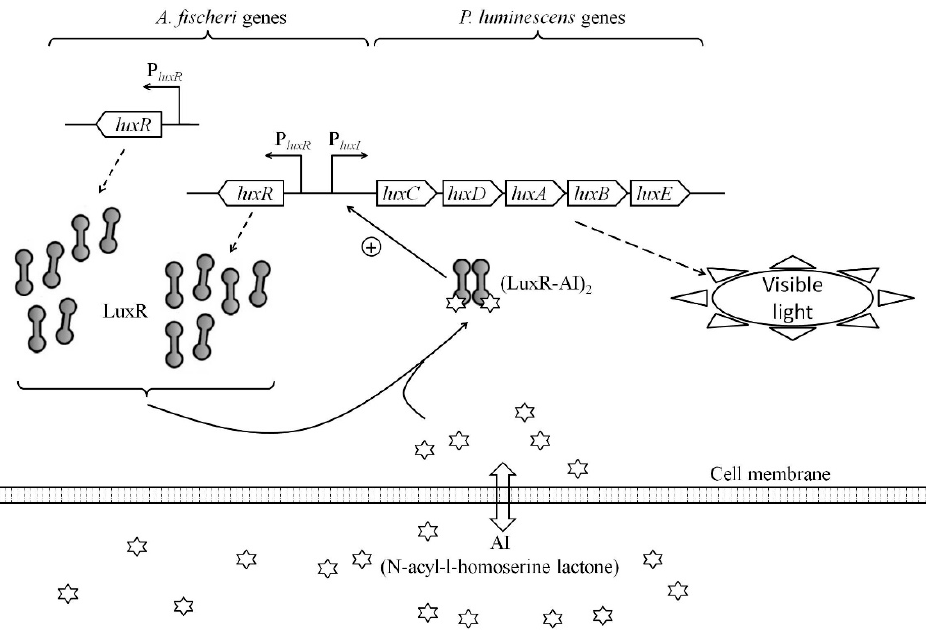
Figure 6. Mechanism of work of the whole-cell luxR -based lux -biosensor with the enhanced luxR A. fischeri dosage.